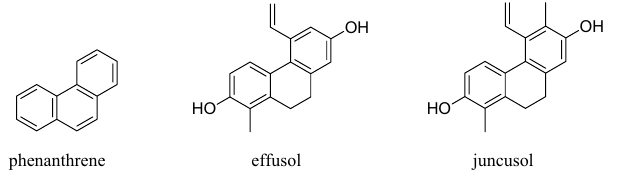
Figure 1. Structures of phenanthrene, effusol and